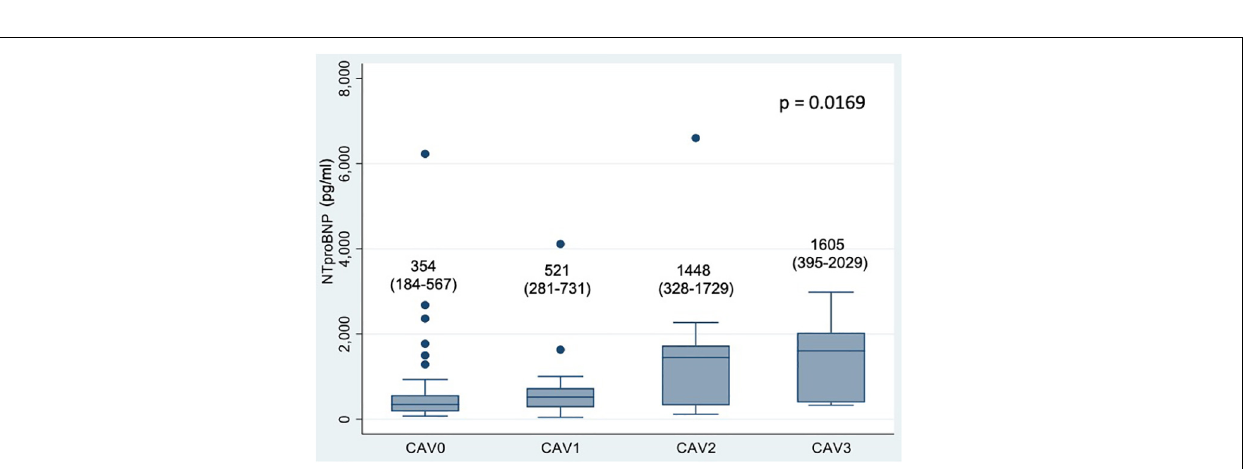
FIGURE 5 | Box-plot of NTproBNP levels according to CAV degree. Numerical data represent median NTproBNP values (pg/ml) and their interquartile range. An outlier value of NTproBNP 26 350 pg/ml in the CAV 0 group was excluded from the figure but included in the analysis.